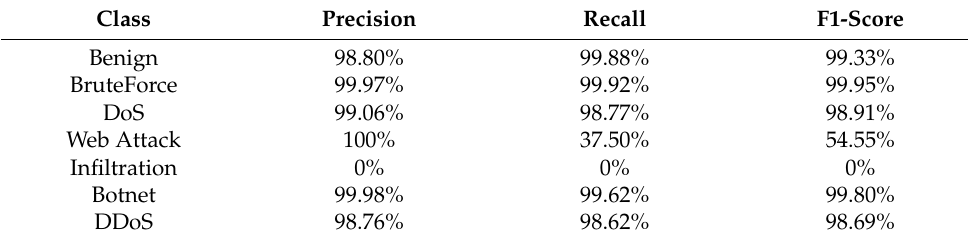
Table 21. DNN evaluation results for multi-class classification.